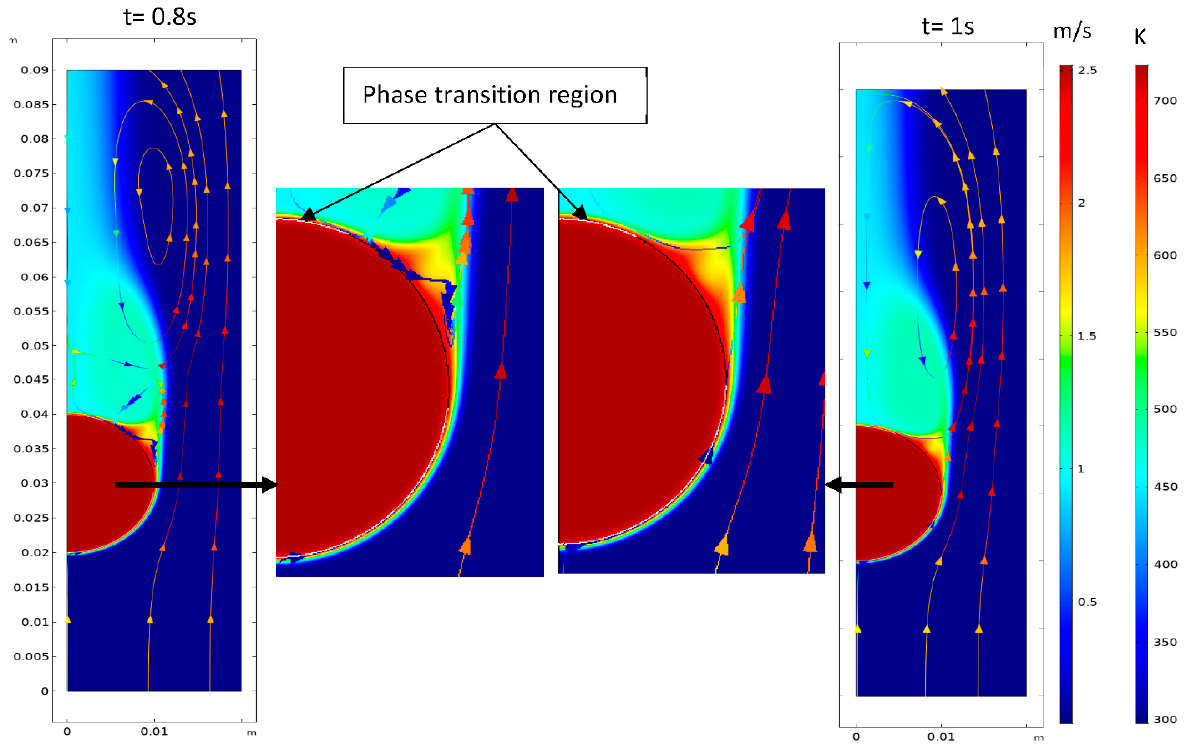
Figure 9. Temperature distribution of N 2 and the droplet (CuCl) domain with a droplet radius of 0.01 m.